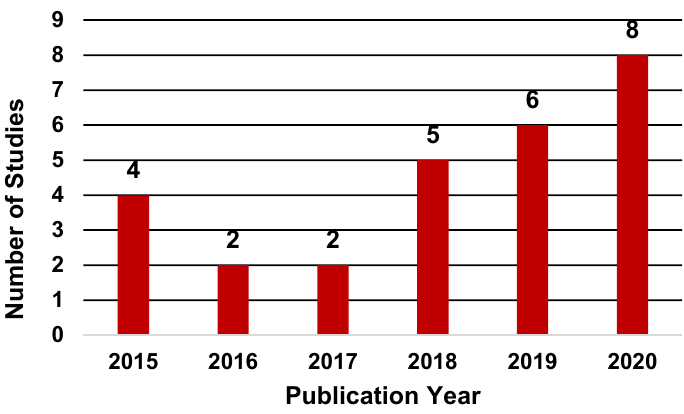
Figure 2. Distribution of studies by publication year.